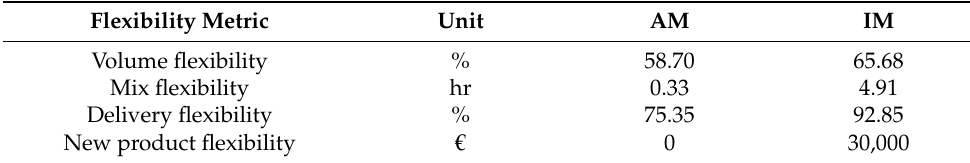
Table 1. Comparison of the flexibility metrics.